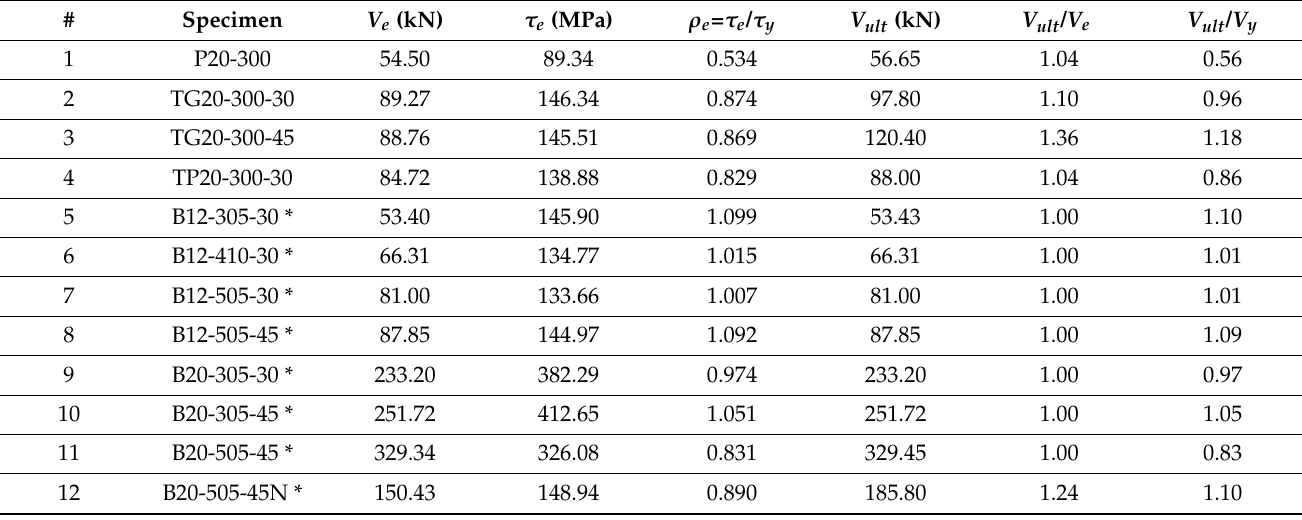
Figure 4. Beam specimens #1–4 modes of failure ( a ) P20-300, ( b ) TG20-300-30, ( c ) TG20-300-45, ( d ) TP20-300-30. Table 2. Experimental shear